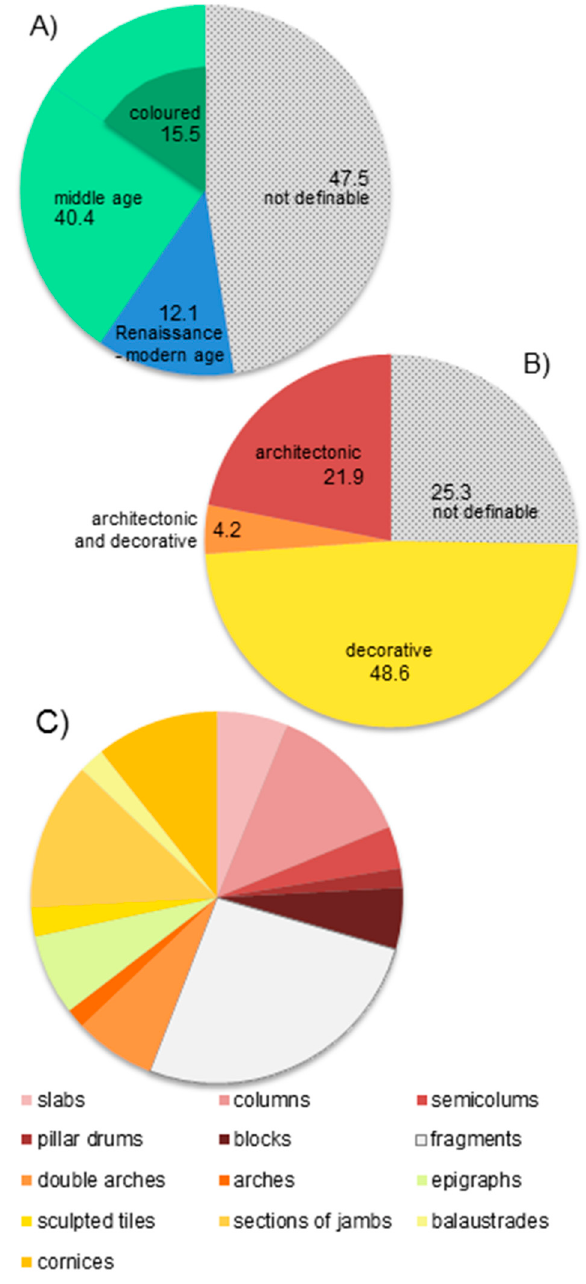
Figure 2. Data analysis. Pie charts showing stylistic and functional data for the 356 fragments. ( A ) Clusters by main epoch, with specification of coloured pieces within medieval fragments. The fragmentation of half of the pieces makes them difficult to date. The majority of the construable pieces pertain to the medieval edifice. ( B ) Clusters by function. Half of the pieces had decorative function. Fragmentary pieces were counted as not definable. ( C ) Clusters by object typology.